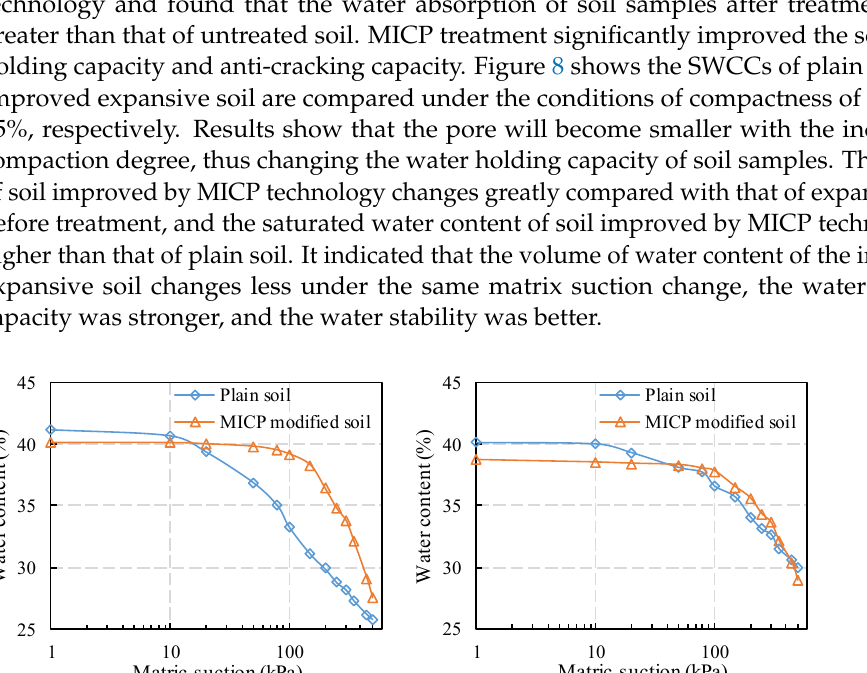
Figure 7. MICP soil infiltration diagram: ( a ) MICP soil diagram before wetting, ( b ) water infiltration into the pores, ( c ) saturated state.